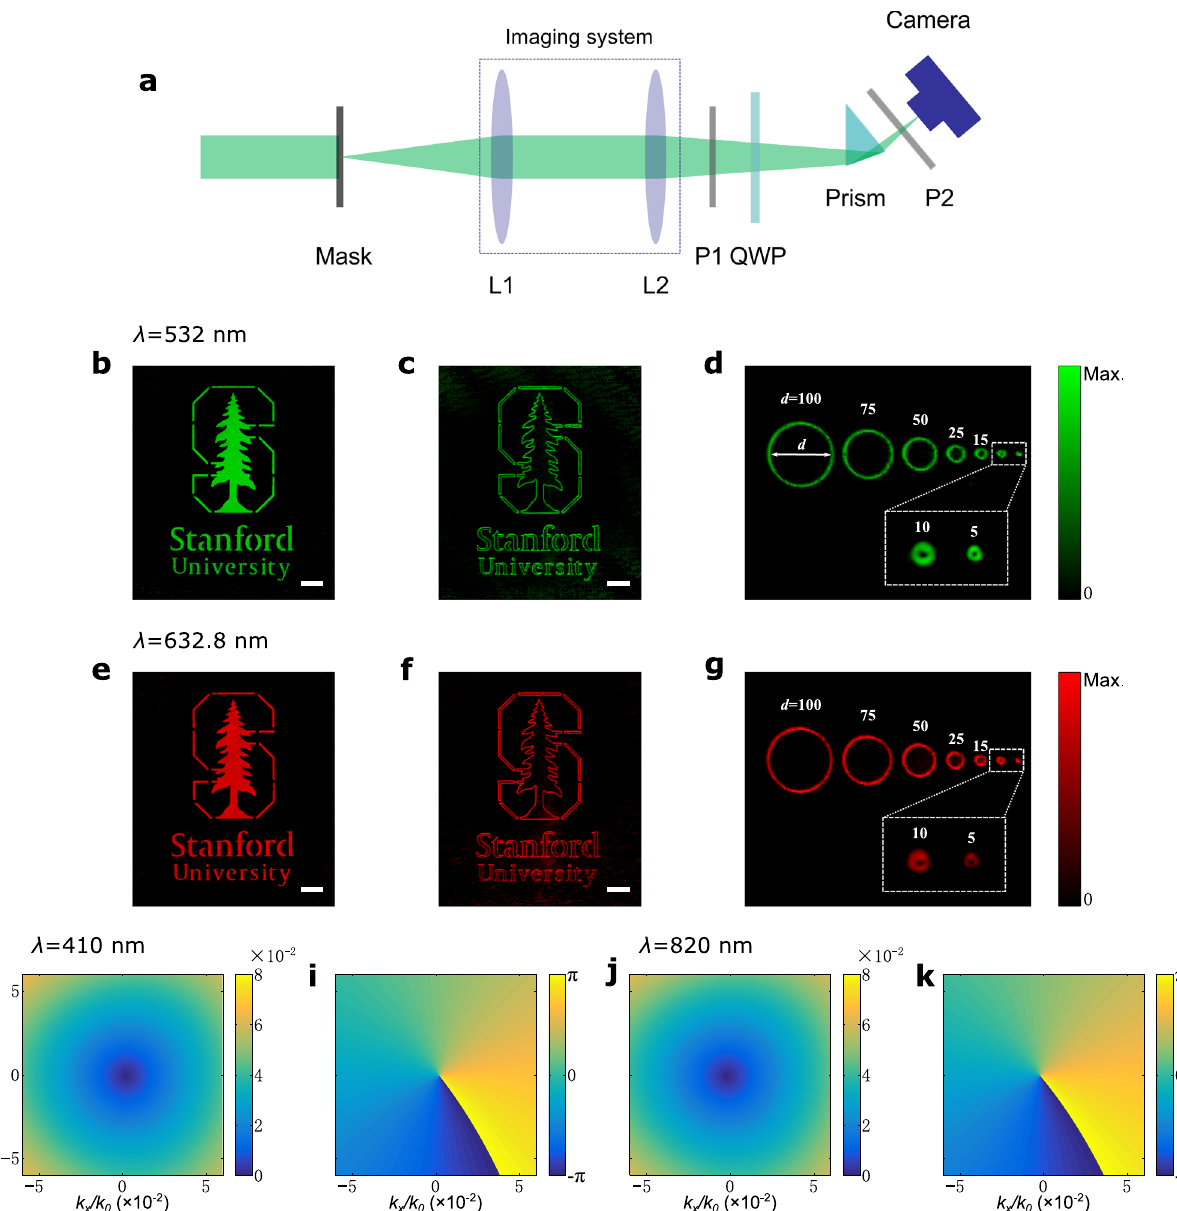
Fig. 4 Demonstration of isotropic edge detection at different wavelengths. a Experimental setups for edge detection when using total internal re fl ection. L1 and L2, lenses; P1 and P2, linear polarizers; QWP, quarter-wave plate. b Incident image of Stanford logo with the illumination wavelength of 532 nm. c Measured image corresponding to ( b ) using setup shown in ( a ). d Resolution test results, corresponding to an input image consisting of an array of full circles with gradually reducing diameters. e – g Same as ( b - d ), except that we operate at the wavelength of 632.8 nm. h , i Numerically calculated magnitudes and phases of the simulated transfer function at the wavelength of 410 nm, respectively. j , k Same as ( h , i ), except that we operate at the wavelength of 820 nm. The white bars correspond to a length of 200 μ m. d in ( d , g ) denotes the diameters of incident full circle patterns in μ